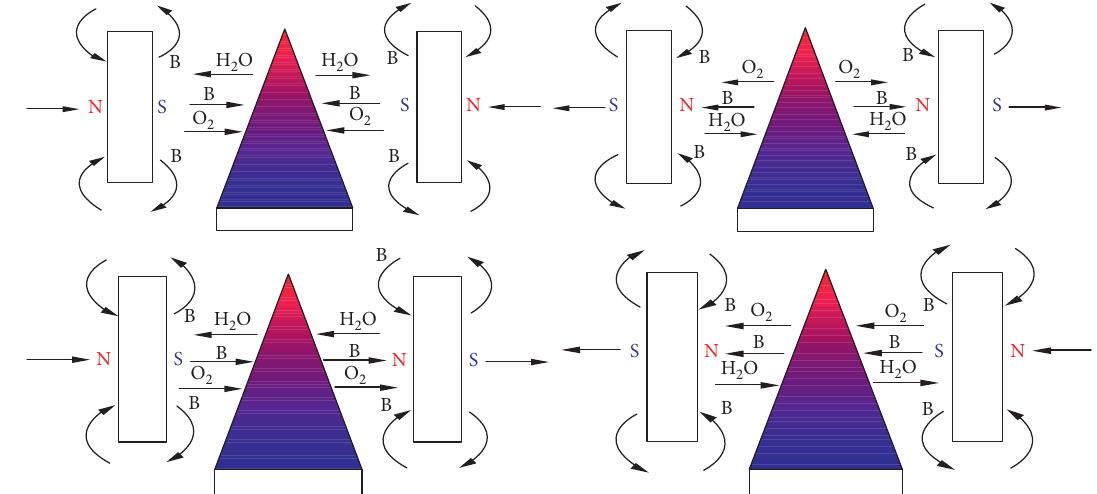
Figure 12: The role of magnetic field orientation on paramagnetic O